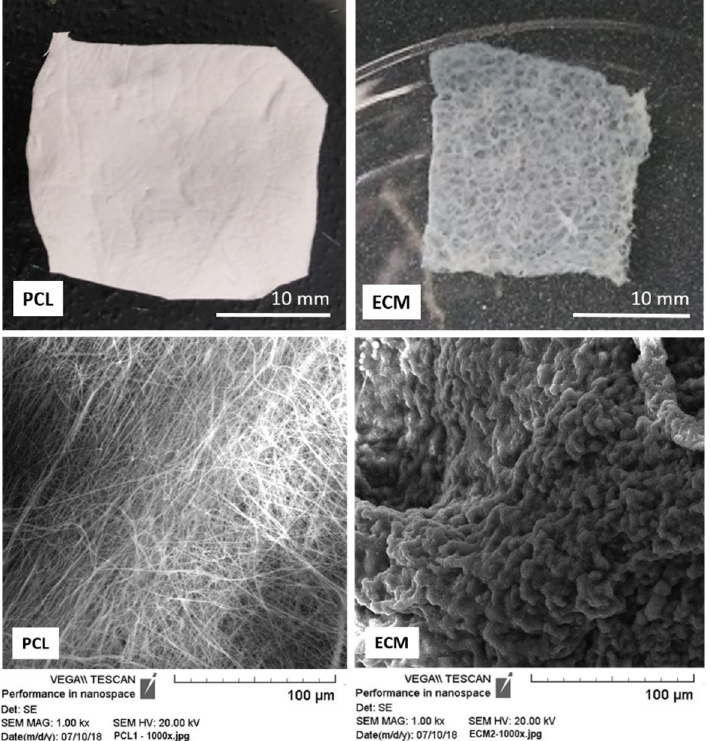
Figure 1. Scaffold samples prepared for comparative bioactivity assessment: electrospun PCL mat and porcine liver ECM. In the lower row are images of the scaffolds taken by SEM. Using the images from SEM (for PCL) and standard light microscopy (for ECM) fiber diameter and pore area distribution were estimated. For the PCL scaffolds, the range of the fiber diameter was from ~100 nm to 2.8 µ m, with a mean diameter of 874 nm (Table